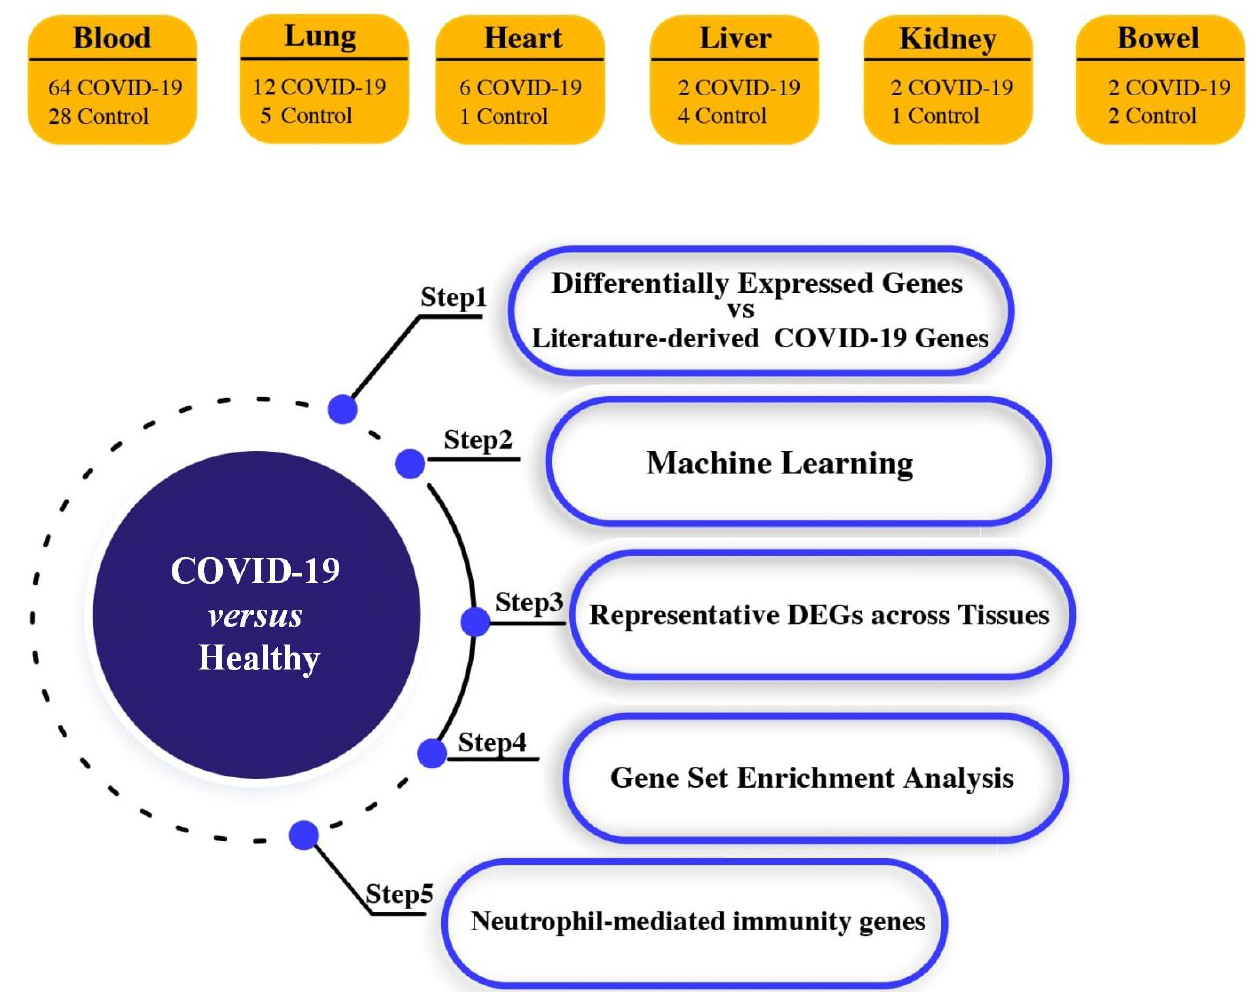
Figure 1. Graphic illustration of the overall methodology of this study.